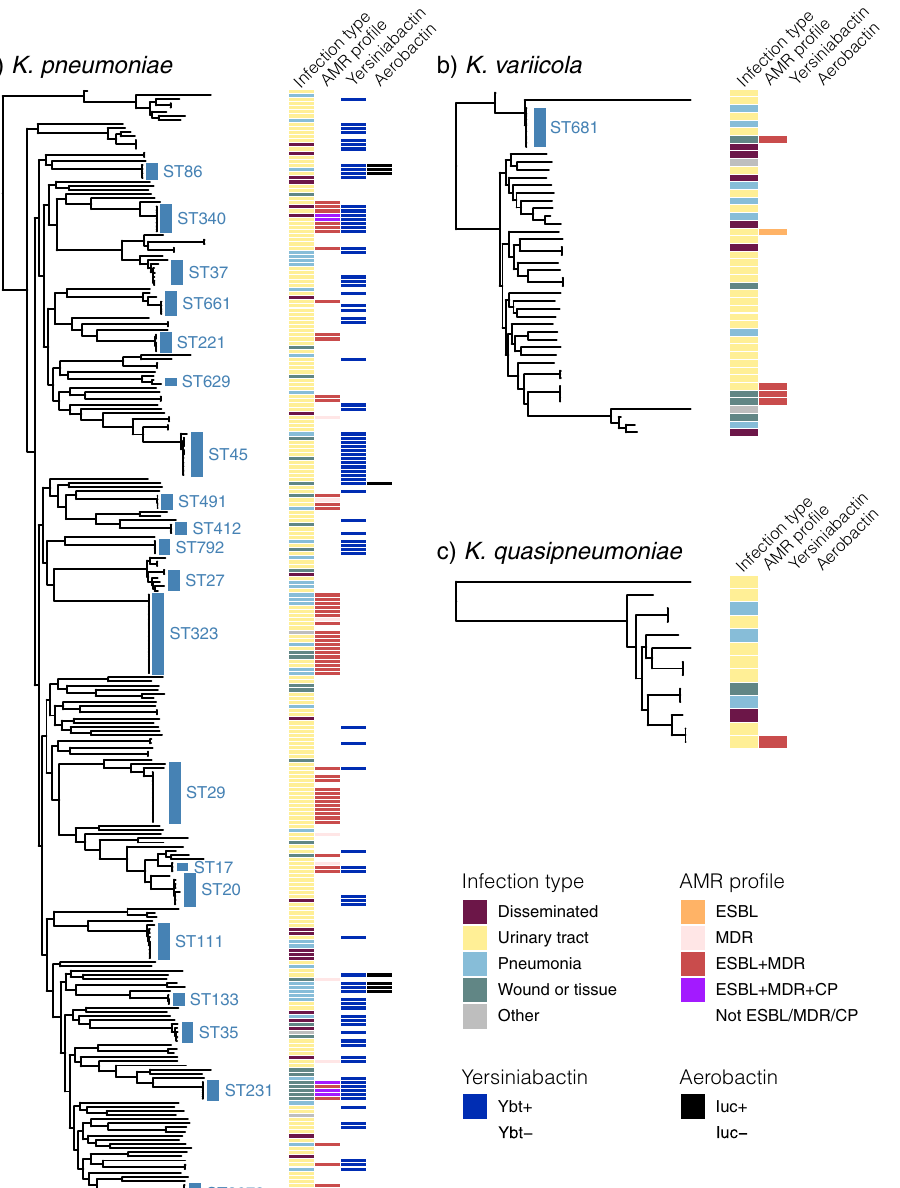
Fig. 2 Core genome phylogenies for K. pneumoniae species complex isolates. a K. pneumoniae , b K. variicola , c K. quasipneumoniae . Trees shown are subtrees extracted from a maximum likelihood phylogeny inferred from a complex-wide alignment of core gene SNVs for all 328 sequenced clinical isolates (i.e., each species tree is rooted using the others as outgroups), available at https://microreact.org/project/kaspahclinical. The 21 ‘ common ’ lineages, each identi fi ed in ≥ 3 patients, are labelled in blue with their sequence type (ST). Columns indicate (1) infection type (disseminated, urinary tract, respiratory, wound/tissue, other); (2) antimicrobial resistance (ESBL, MDR, ESBL + MDR, ESBL + MDR + CP); (3) yersiniabactin (Ybt + , identi fi ed in K. pneumoniae only); (4) aerobactin (Iuc + , identi fi ed in K. pneumoniae only); coloured as per inset legend. ESBL = extended spectrum beta-lactamase, MDR = resistant to rep markers were signi fi cantly correlated across genomes (Pearson correlation coef fi cient = 0.614, p < 1 x 10 − 15 ), and both were signi fi cantly independently associated with total DNA in contigs predicted to be plasmid-derived (see Fig. 4). In total, 252 infection episodes (86%) had predicted plasmid load ≥ 5 kbp (89% with >0 bp, 85% with ≥ 10 kbp). Amongst these presumptive plasmid-positive genomes, median plasmid load was 233 kbp (range 7.3 – 704 kbp, IQR 171 – 306 kbp).